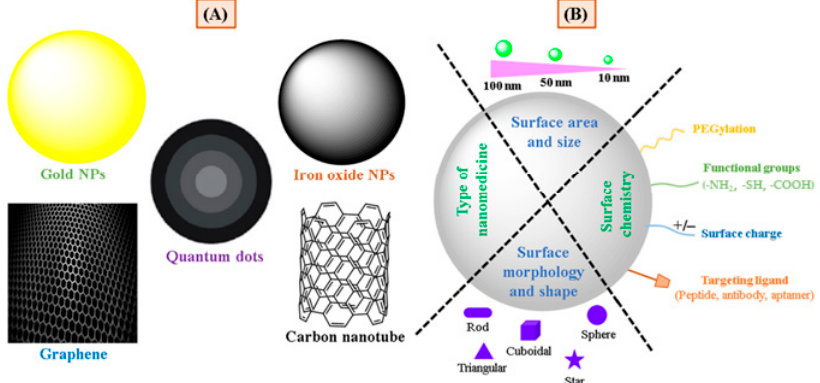
Figure 1. ( A ) Different types of nanomedicine utilized in cancer diagnosis and therapy; ( B ) various physicochemical characteristics of nanomedicine influencing its biopharmaceutical performance.